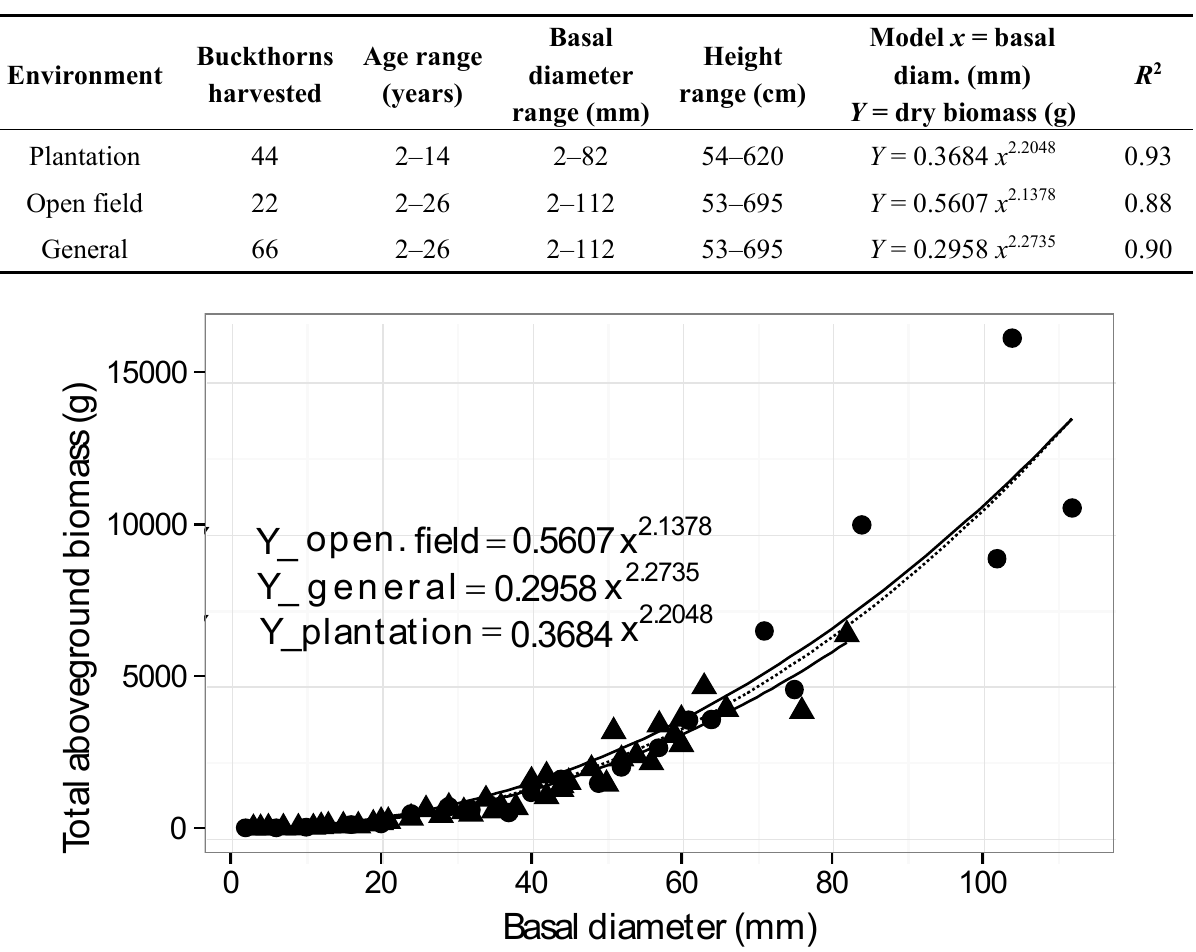
Table 1. Allometric relationships between basal diameter of buckthorns, as the predictor variable ( x ), and total aboveground biomass, as the response variable ( Y ), in open field and plantation understory light environments.